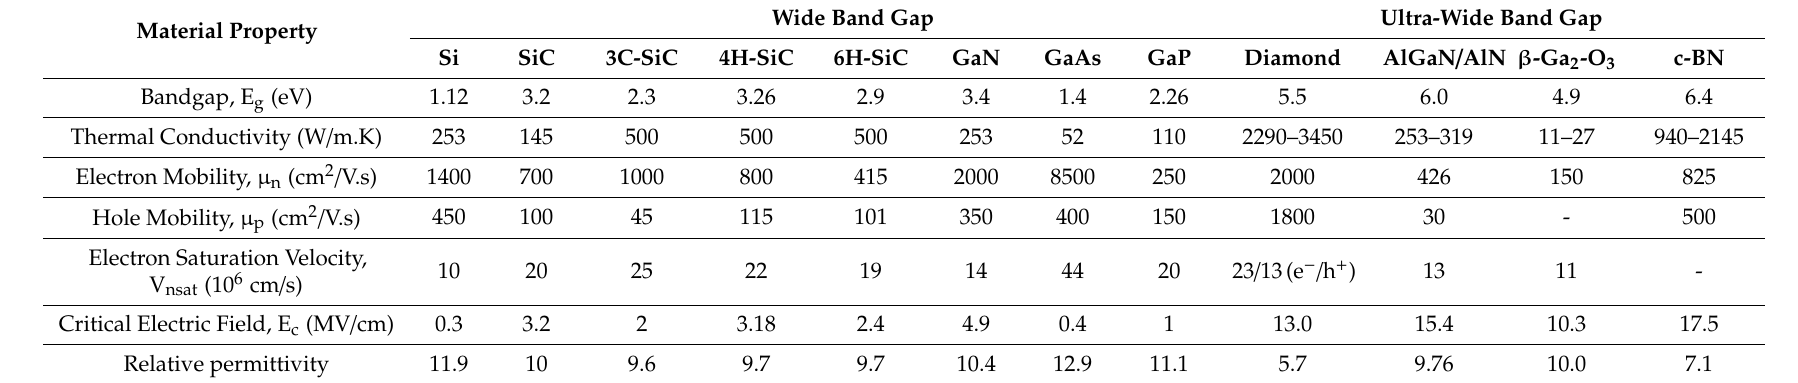
Table 4. Properties and Electrical Characteristics of Semiconductor Materials